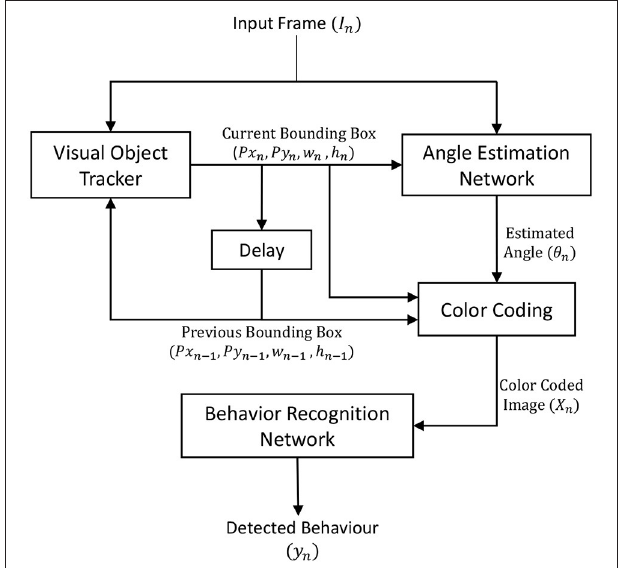
FIGURE 1 | Overview of the proposed